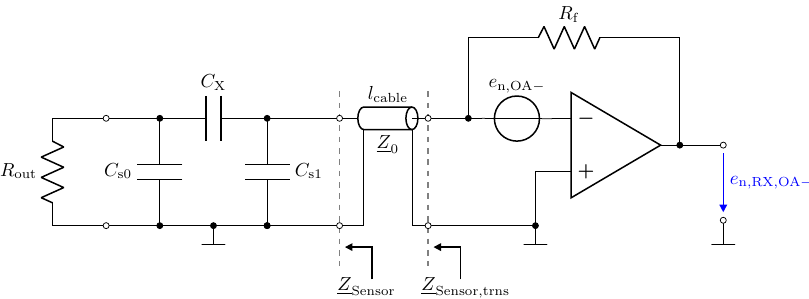
Figure 15. Circuit configuration of the low-Z input stage to determine its output voltage noise. As an example, the voltage noise spectral density e n,OA − of the inverting amplifier input and its resulting output voltage noise spectral density e n,RX,OA − are shown. R out = 50 Ω , R f = 500 Ω , C X = 1pF and C s0 = C s1 =